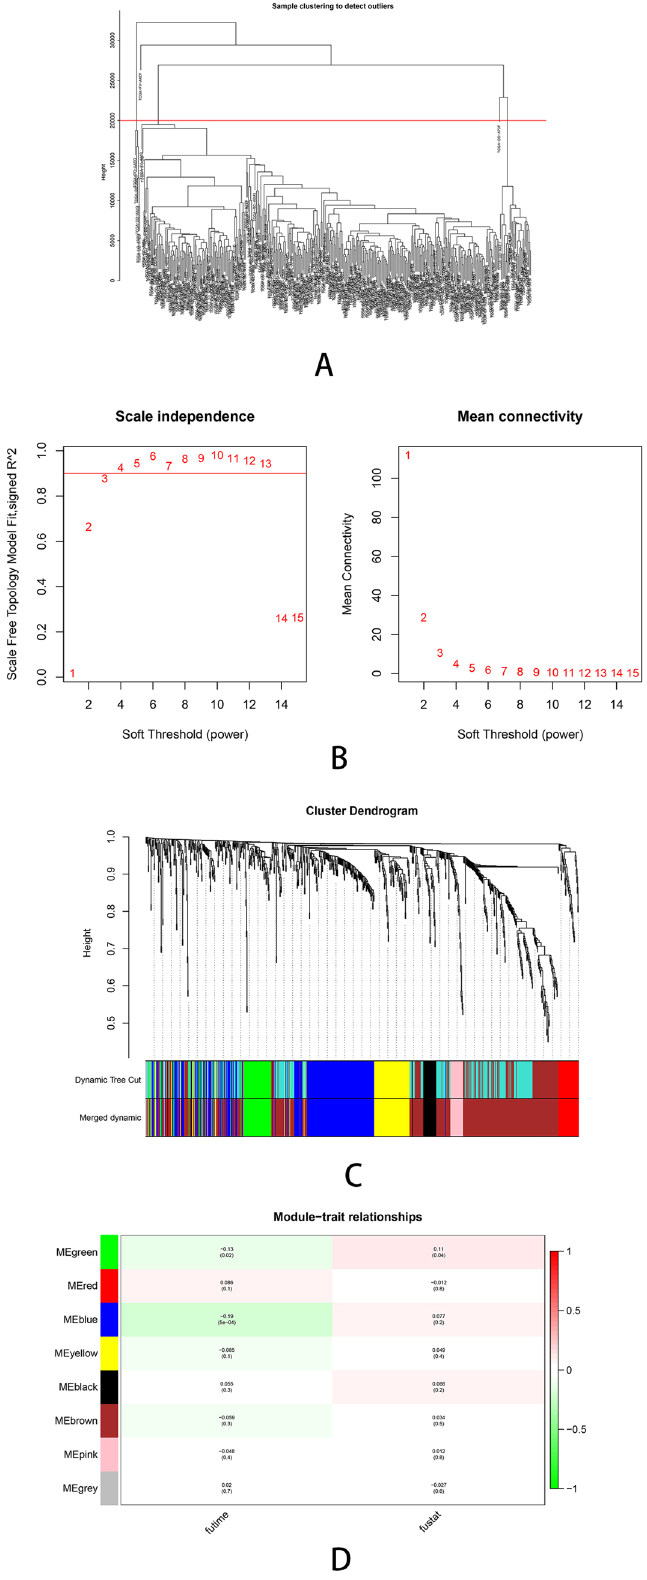
Figure 2. Weighted gene correlation network analysis. (A) The samples hierarchical clustering tree, height greater than 20,000 has been removed. (B) The scale ‐ free fit index for soft ‐ thresholding powers. The soft ‐ thresholding powers was identified based on a scale ‐ free R2 = 0.9. (C) The cluster dendrogram plotted by dynamic pruning method. Each branch in the figure represents one gene, each color below represents one co ‐ expression module. (D) The heatmap for the correlation between clinical traits and gene